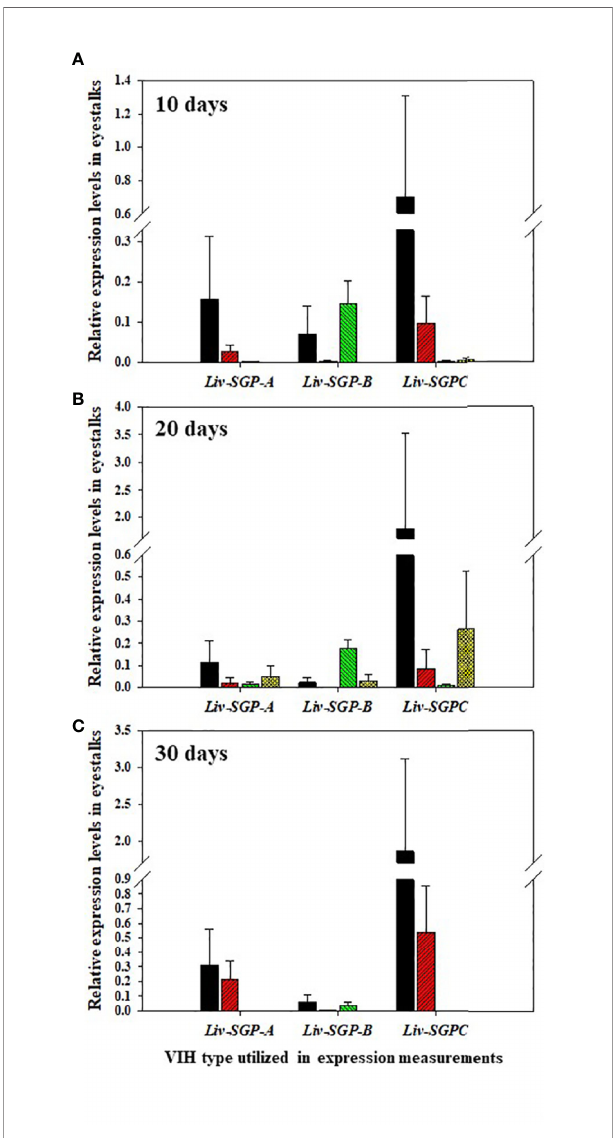
FIGURE 5 | Relative expression levels of Liv-SGP-A , -B , and -C in eyestalks. (A) 10 days following a single injection of GFP-dsRNA (n = 5), sgpG-dsRNA (n = 6), sgpC-dsRNA (n = 6), or mixed-dsRNA (n = 6). (B) 20 days following a single injection of GFP-dsRNA (n = 6), sgpG-dsRNA (n = 6), sgpC-dsRNA (n = 6), or mixed-dsRNA (n = 5). (C) 30 days following a single injection of GFP-dsRNA (n = 4), sgpG-dsRNA (n = 6), sgpC-dsRNA (n = 4), or mixed- dsRNA (n = 4). Results are expressed as the mean ± SEM. Results for each treatment groups are expressed in the bar graphs using the follows colors. Black: GFP-dsRNA group; red: sgpG-dsRNA; green: sgpC-dsRNA; yellow: